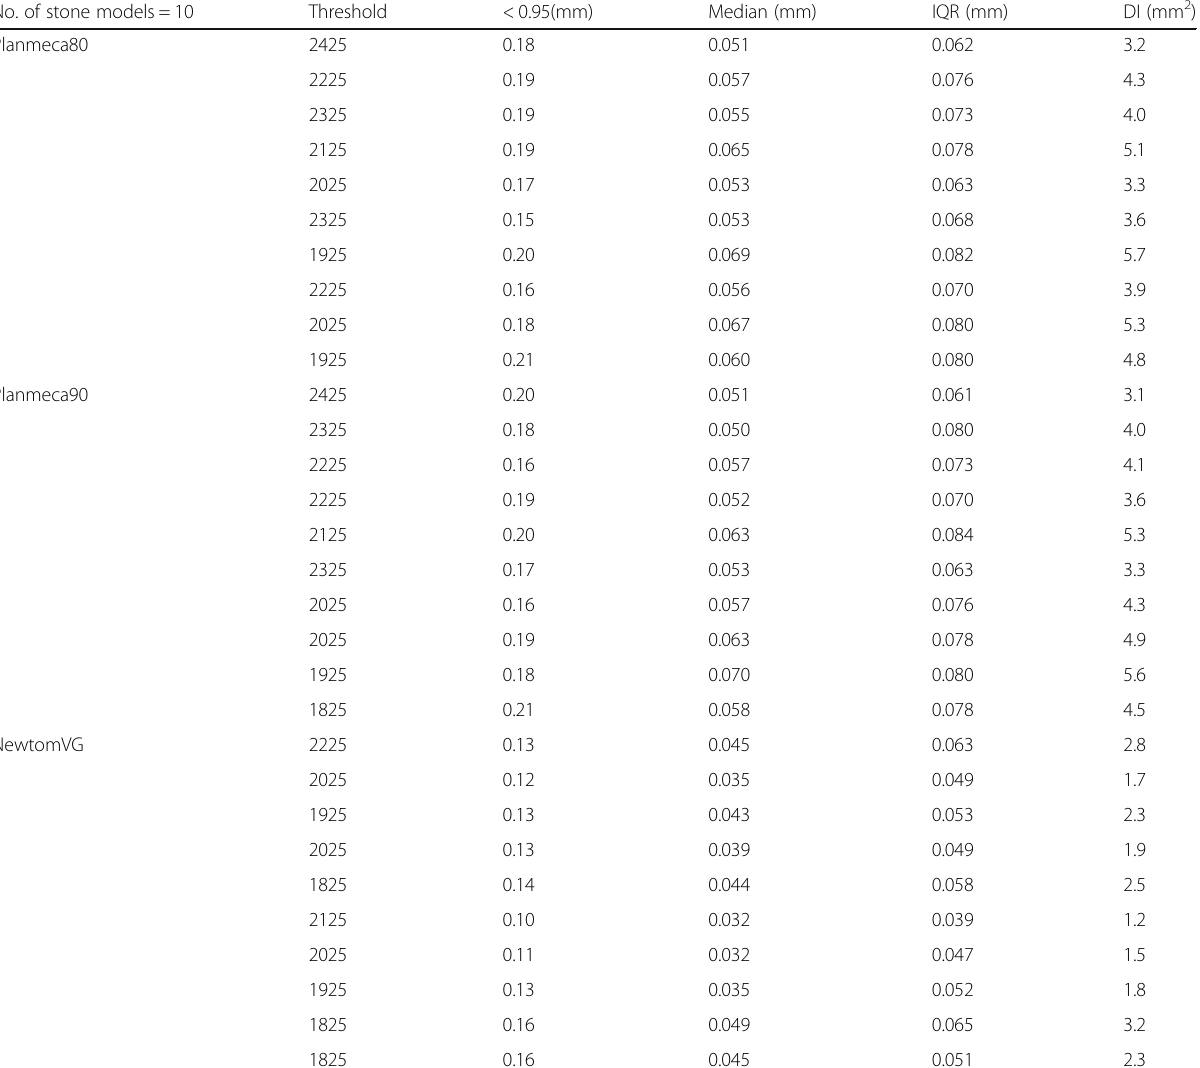
Table 2 Various statistics for the CBCT meshes with the lower (best) Dissimilarity Index per case No. of stone models =